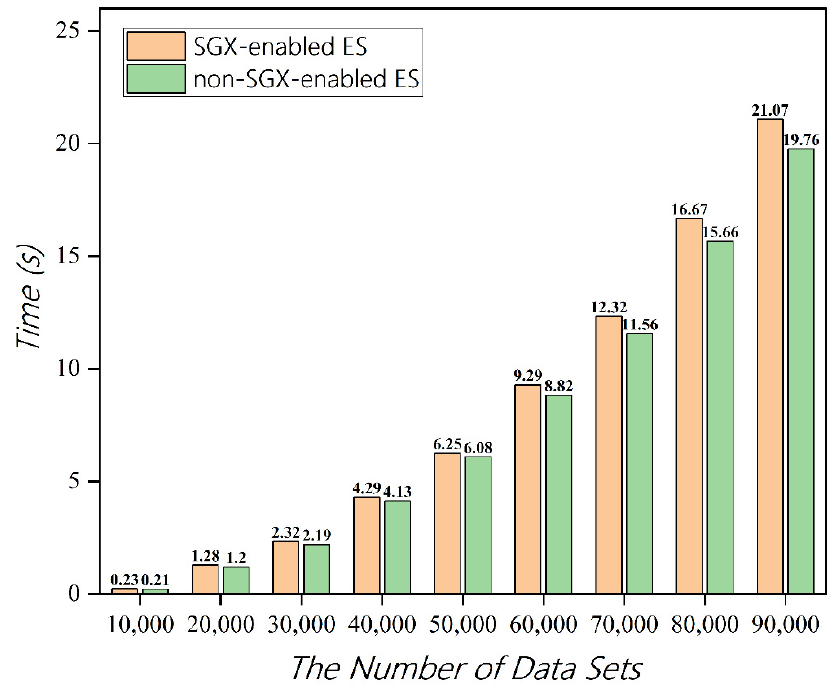
Figure 10. Performance comparison between non-SGX-enabled and SGX-enabled machines.